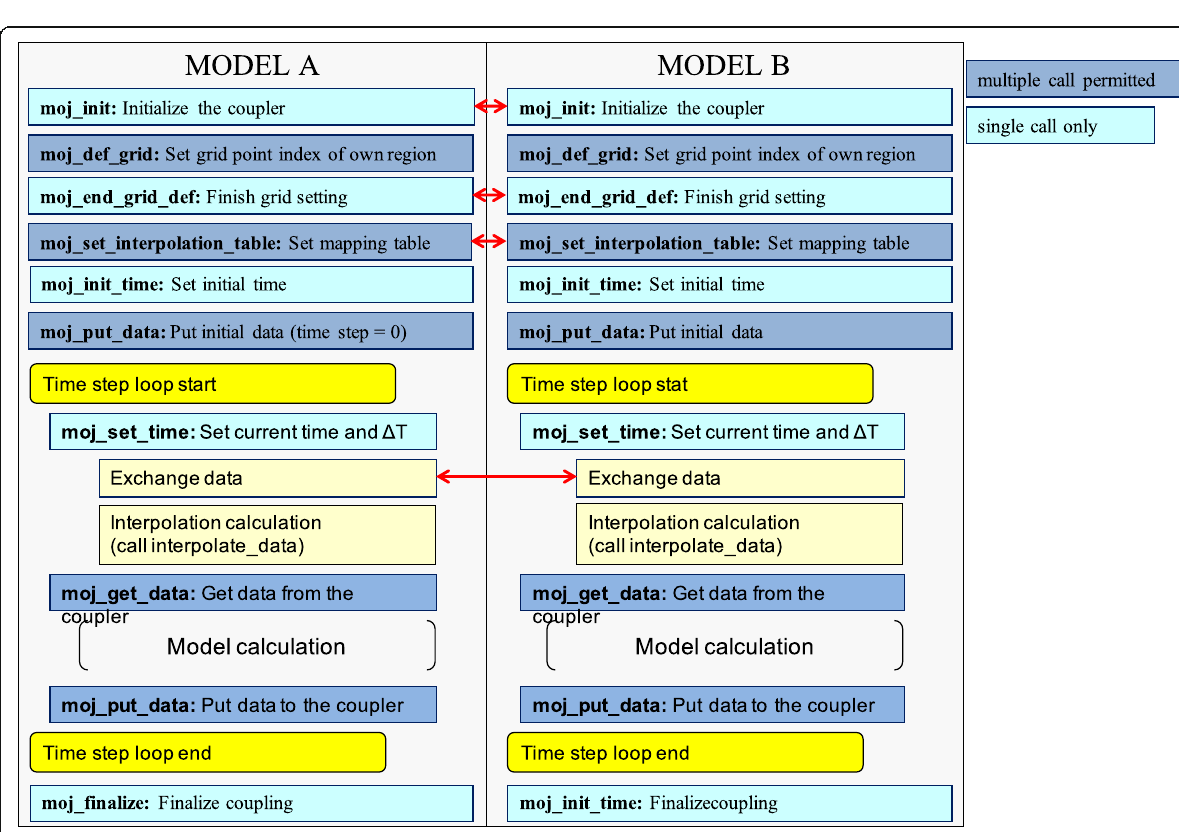
Fig. 3 Example of typical usage of the Jcup API subroutines. The blue squares represent the subroutines that can be called multiple times. The light blue squares indicate the subroutines that can be called only once. The red arrows indicate that communication is performed in the subroutines. The cream squares represent operations inside moj_set_time. Data exchange and interpolation calculations were performed inside